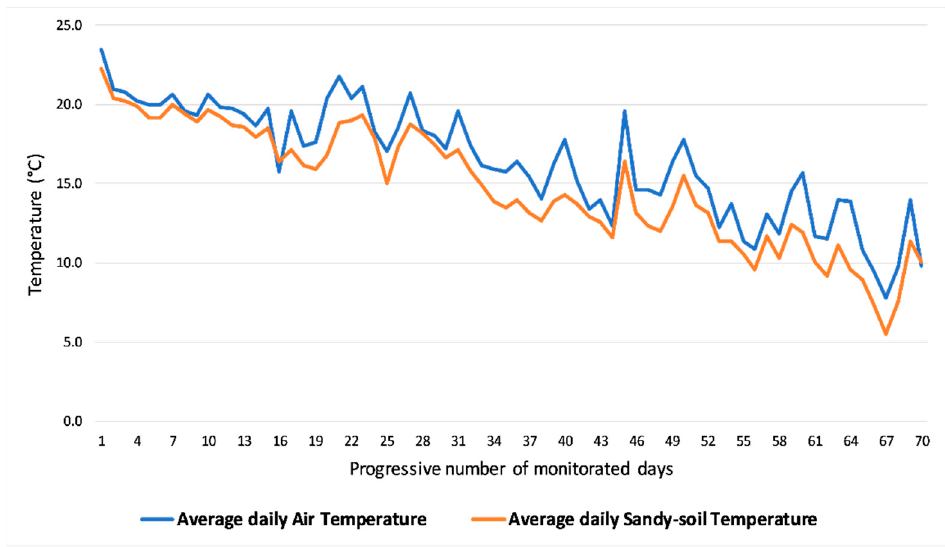
Figure 5. Daily average air and sandy soil surface temperature during the monitoring period. Table 1. Extreme values of average temperature.